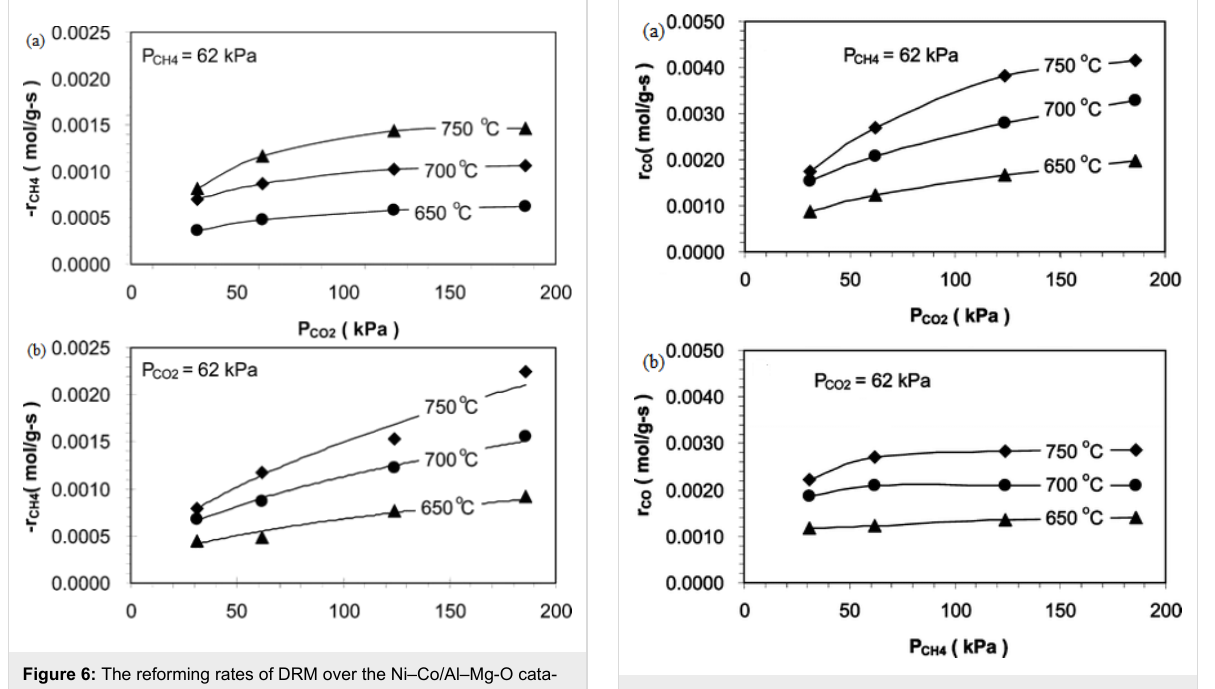
Figure 7: The formation rates of CO affected by (a) CH 4 partial pres- sure and (b) CO 2 partial pressure at different temperatures. Reprinted from [86], copyright 2009 American Chemical Society.